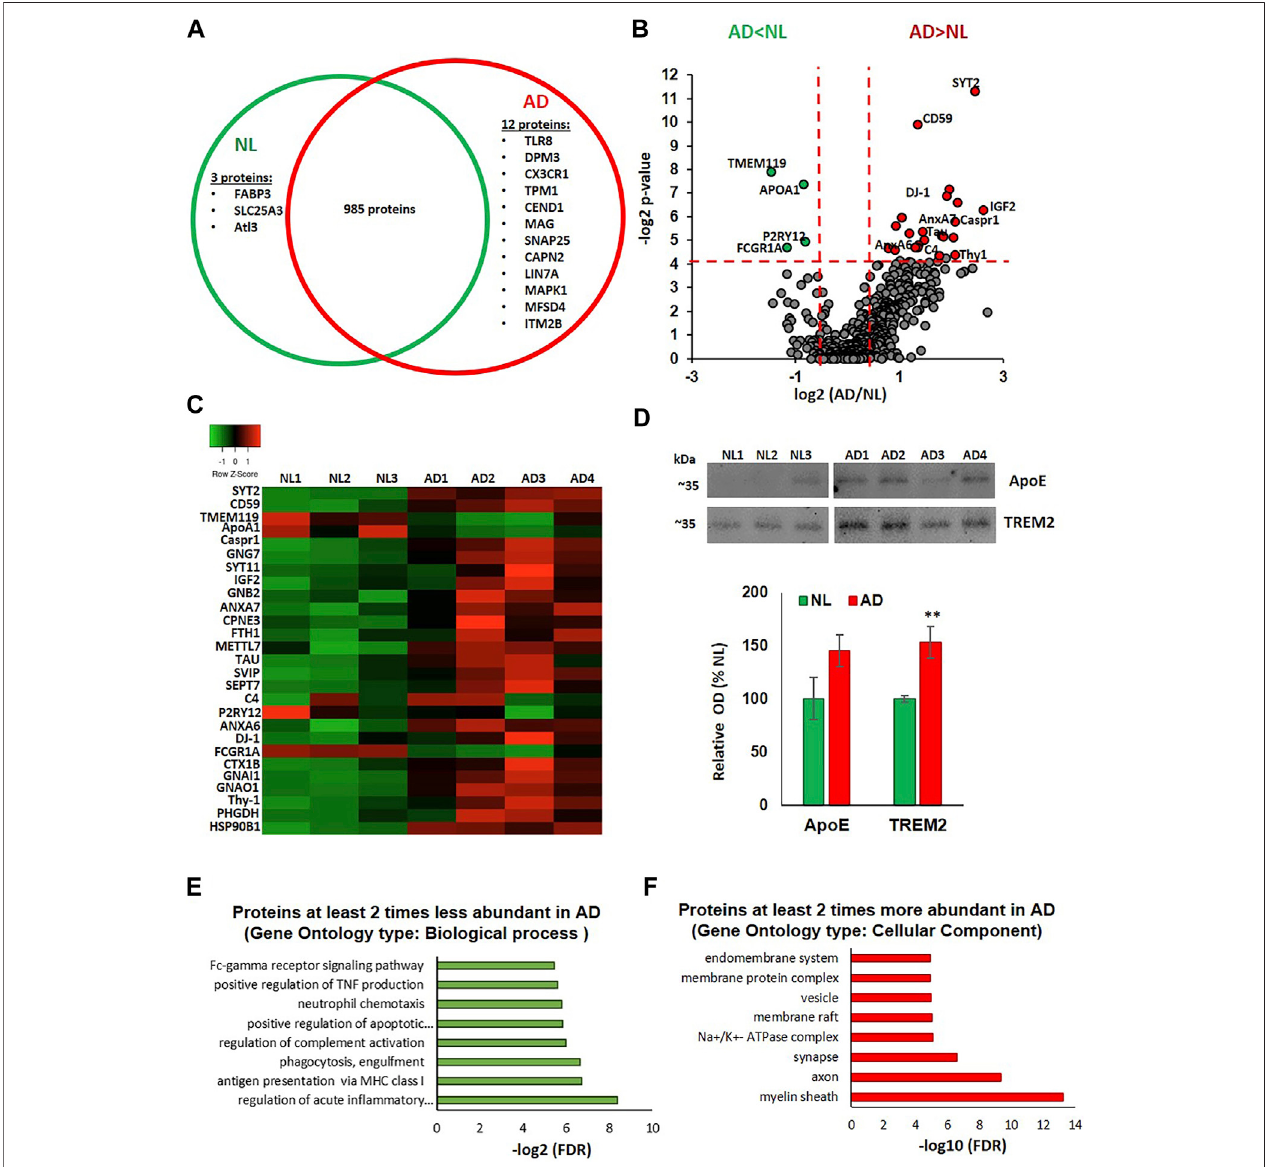
FIGURE 2 | Proteomic analysis of microglial EVs from normal/low pathology and late-stage AD cases. (A) Venn diagram representing microglial proteins differentially detected in NL and AD groups. (B) Volcano plot showing a degree of differential expression of proteins in NL and AD groups. Vertical red dotted lines separate proteins, which are two or more times less abundant in AD (far left segment) and two or more times more abundant in AD (far right segment). Horizontal red dotted line separates the top part of the plot containing dots representing proteins whose abundances are signi fi cantly different between NL and AD groups ( p < 0.05)andthebottompart(nosigni fi cantchanges).Proteinsthataresigni fi cantlydifferentbetweenADandNLgroupsarecolor-coded:twoormoretimesmoreabundant in AD are presented in red, two or more times less abundant in green. (C) Heat map of proteins signi fi cantly up- and downregulated in AD compared to the NL group across seven evaluated human cases. (D) Immunoblotting of CD11b-IP samples with antibodies against ApoE and TREM2. Representative images are in the upper section and the composite data are in the lower section (* p < 0.05). (E) Gene ontology enrichment bioinformatic analysis of proteins two or more times less abundant in AD compared to NL. (F) Gene ontology enrichment bioinformatic analysis of proteins two or more times more abundant in AD compared to NL.